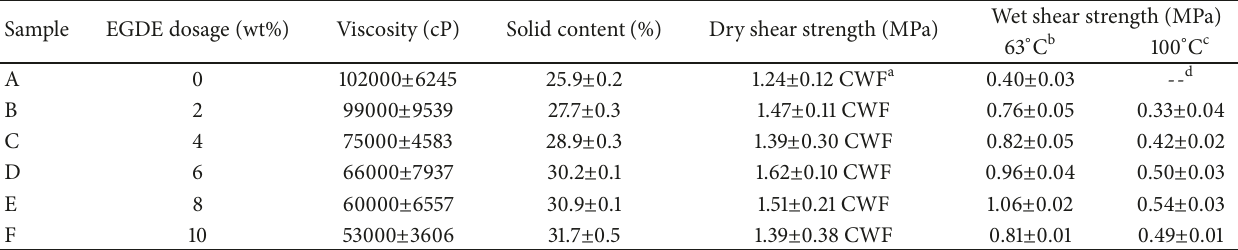
Table 1: Effects of EGDE dosage on the performance of SF adhesive and SF adhesive-based plywood.